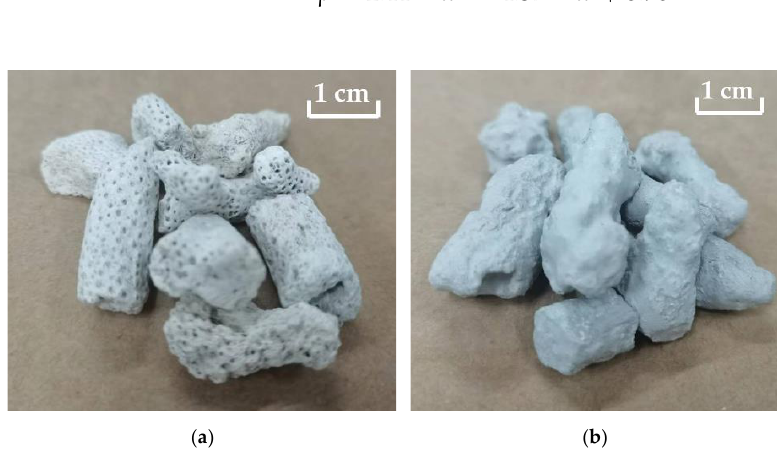
Figure 3. Appearance of coral aggregates: ( a ) unmodified; ( b ) modified.